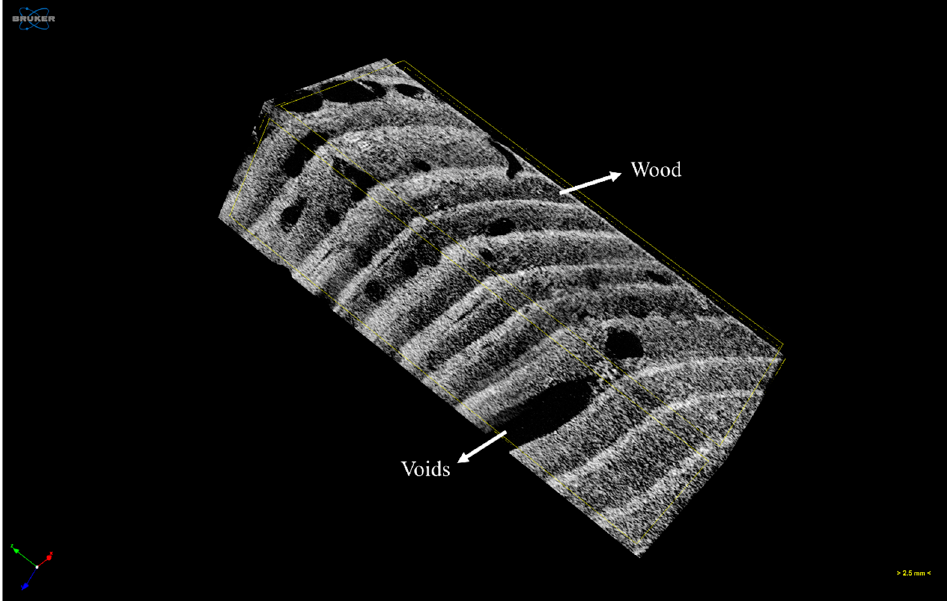
Figure 4. Reconstructed 3D object. Visualization using CTVox software.